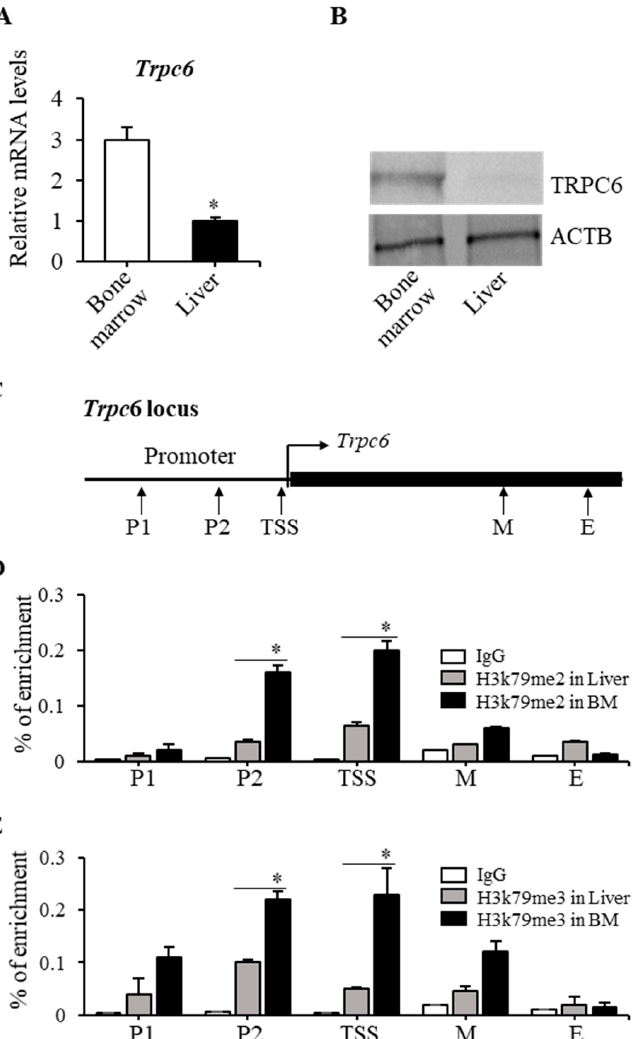
Figure 5. Enrichment of di- and tri-methyl H3K79 in Trpc6 gene loci. Trpc6 expression was tested by RT-qPCR in bone marrow (BM) and liver cells. Trpc6 mRNA levels were significantly higher in BM cells compared to that in liver cells ( A ). TRPC6 protein was also detected in BM and liver cells by Western blot analysis, which showed that TRPC6 protein was also markedly higher in BM cells ( B ). ChIP assays were performed on chromatin preparations from BM and liver cells to assess H3K79 di- and tri-methylation in the Trpc6 gene locus. ( C ) Several pairs of primers were designed covering the Trpc6 gene locus including the promoter region (P1, P2), transcription start site (TSS), and middle and end of the gene locus (M, E). ChIP assays were performed in the promoter region of Trpc6 gene locus for H3K79 di-methylation ( D ) and H3K79 tri-methylation ( E ). There was significantly greater enrichment of both H3K79 di- and tri-methylation at the P1, P2, and TSS sites of the Trpc6 gene in BM cells than that of liver cells. The ChIP-qPCR data represent 3 independent experiments. Data are expressed as the mean ± SE; n > 6; * p < 0.05.